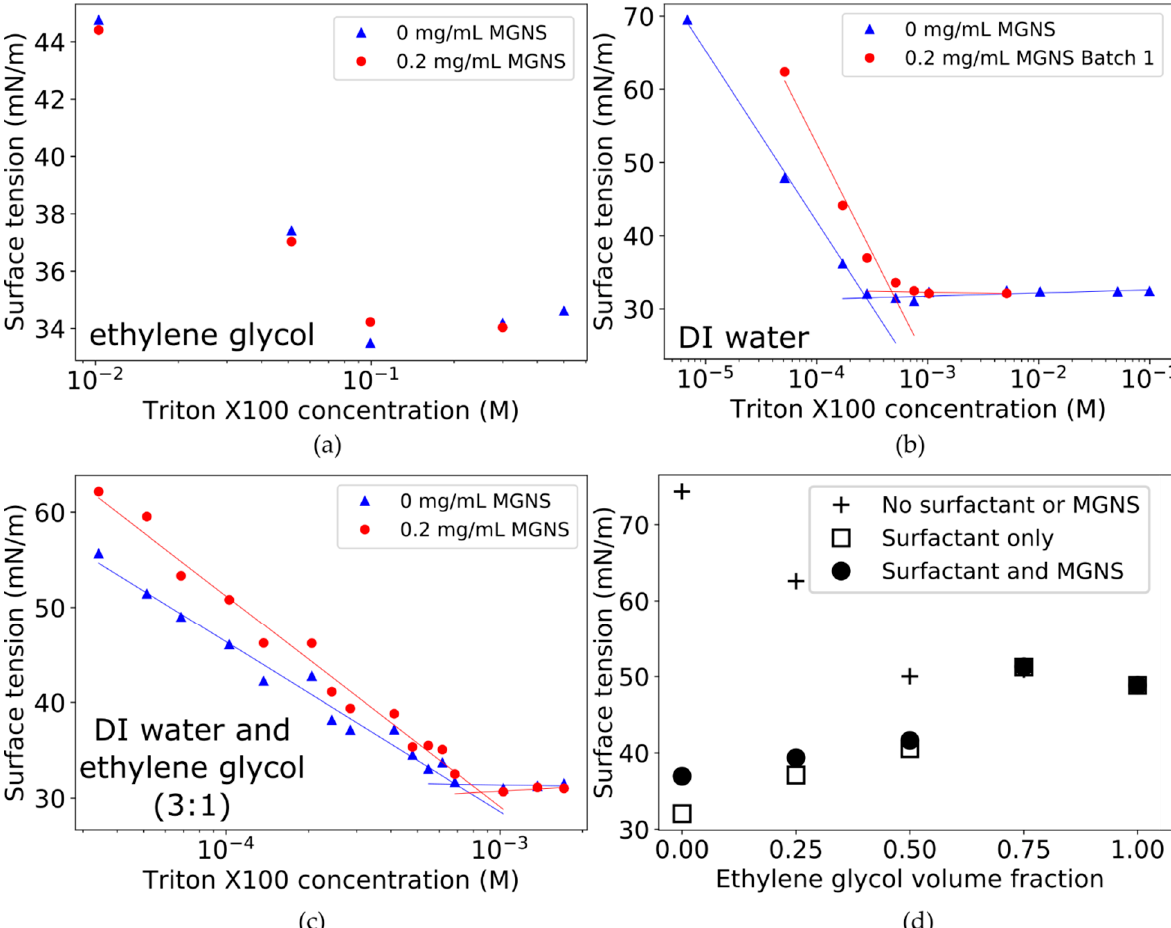
Figure 5. Surface tension as a function of surfactant concentration with (red points) and without (blue triangles) 0.2 mg/mL of dispersed MGNS in ( a ) ethylene glycol; ( b ) DI water; ( c ) a 3:1 mixture of DI water and ethylene glycol; and ( d ) surface tension of mixtures of DI water and ethylene glycol with and without a constant concentration of surfactant and dispersed MGNS.